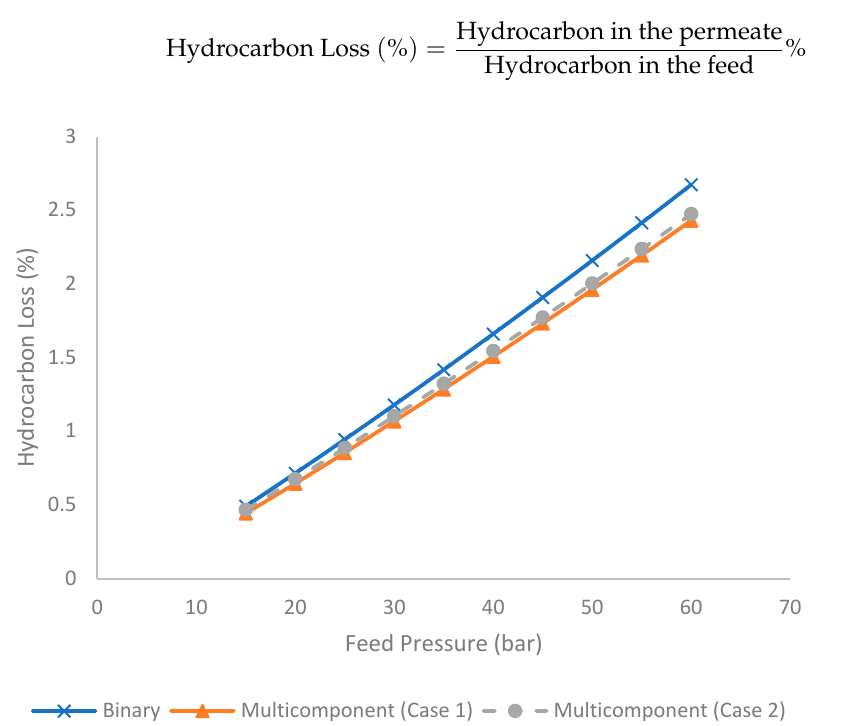
Figure 6. Evolution of hydrocarbon loss (%) under different feed pressures for binary and multicomponent systems.